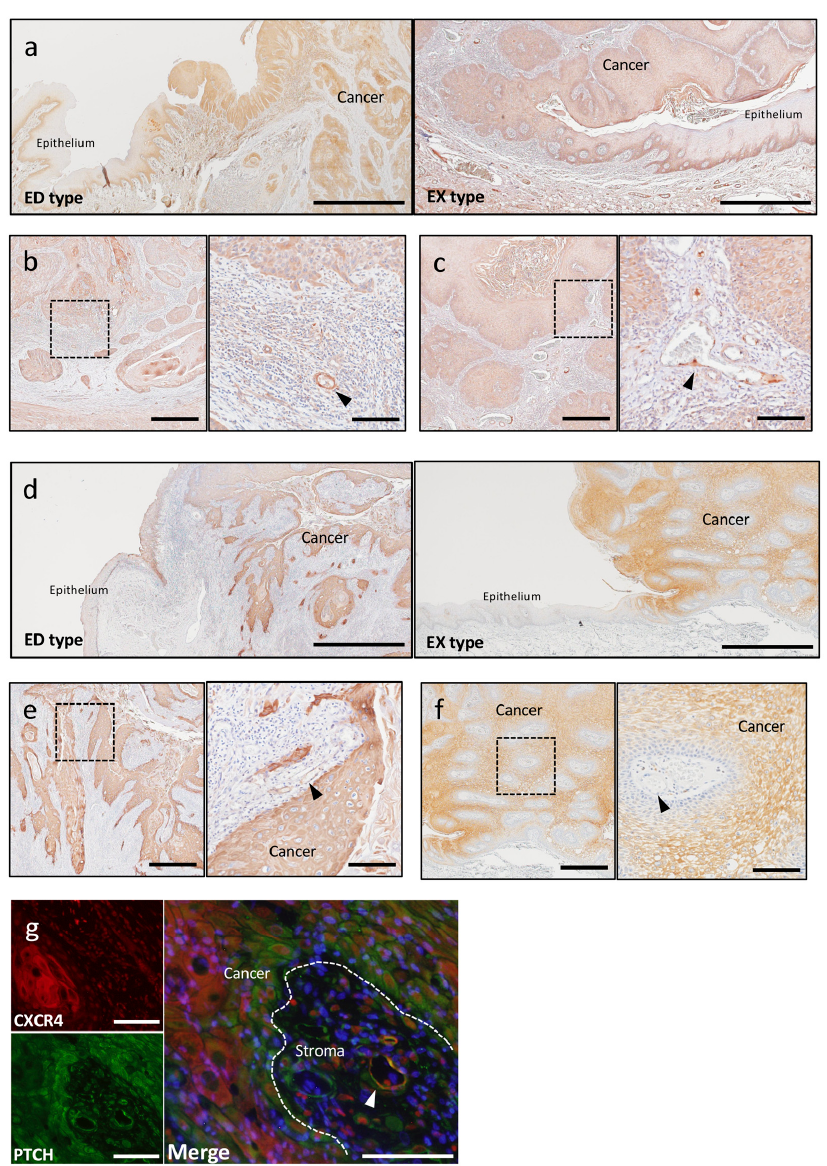
Figure 3. IHC and immunofluorescence of SDF-1 and CXCR4. ( a ) IHC staining for SDF-1 in ED type and EX type. SDF-1 was expressed in both ED-type and EX-type cancer parenchyma; however, SDF-1 was not expressed in the non-cancerous epithelium adjacent to the cancer parenchyma. Scale bar: 1 mm. ( b ) IHC feature of SDF-1 in ED type. Blood vessels (arrowhead) were positive for SDF-1 in invasive front of cancer. Scale bar, left: 500 µ m, right: 100 µ m. ( c ) IHC feature of SDF-1 in EX type. Blood vessels (arrowhead) were positive for SDF-1 weakly in cancer stroma. Scale bar, left: 500 µ m, right: 100 µ m. ( d ) IHC staining for CXCR4 in ED type and EX type. CXCR4 was expressed in both ED-type and EX-type cancer parenchyma; however, CXCR4 was not expressed in the non-cancerous epithelium adjacent to the cancer parenchyma. Scale bar: 1 mm. ( e ) IHC feature of CXCR4 in ED type. Blood vessels (arrowhead) were positive for CXCR4 in cancer stroma. Scale bar, left: 500 µ m, right: 100 µ m. ( f ) IHC feature of CXCR4 in EX type. Blood vessels (arrowhead) were not positive for CXCR4 in cancer stroma. Scale bar, left: 500 µ m, right: 100 µ m. ( g ) Double-fluorescent IHC in ED type. Double-fluorescent IHC staining of CXCR4 and PTCH demonstrated that the CXCR4-positive blood vessels merged with PTCH in ED type (arrowhead). Scale bar: 100 µ